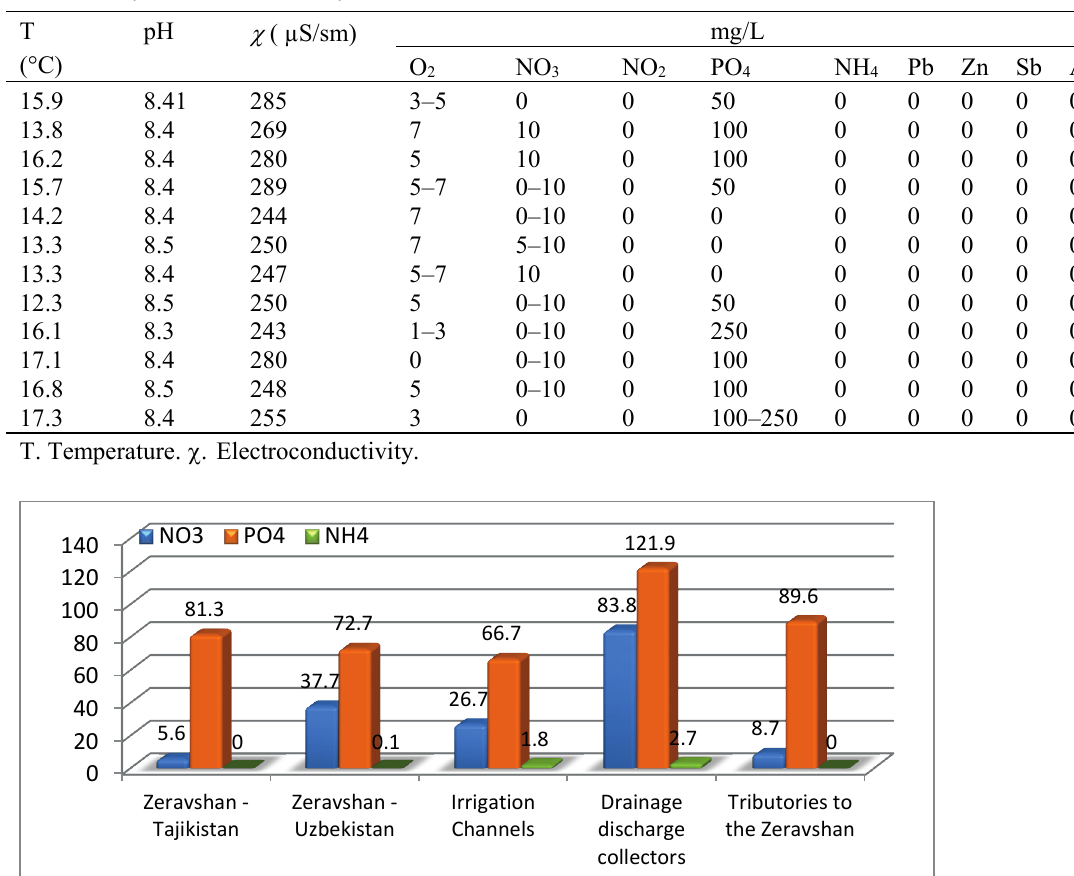
Table 1 Physical - chemical analyses results of Zeravshan River waters.